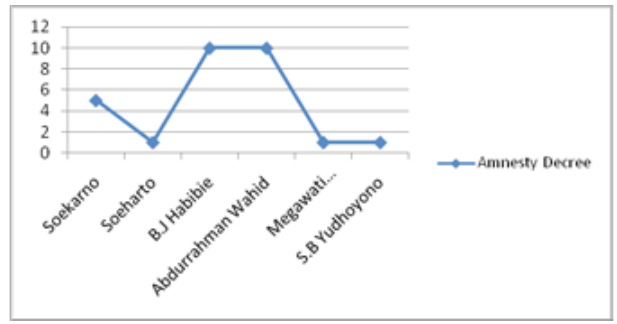
Figure 1: Amnesty Decree in Indonesia